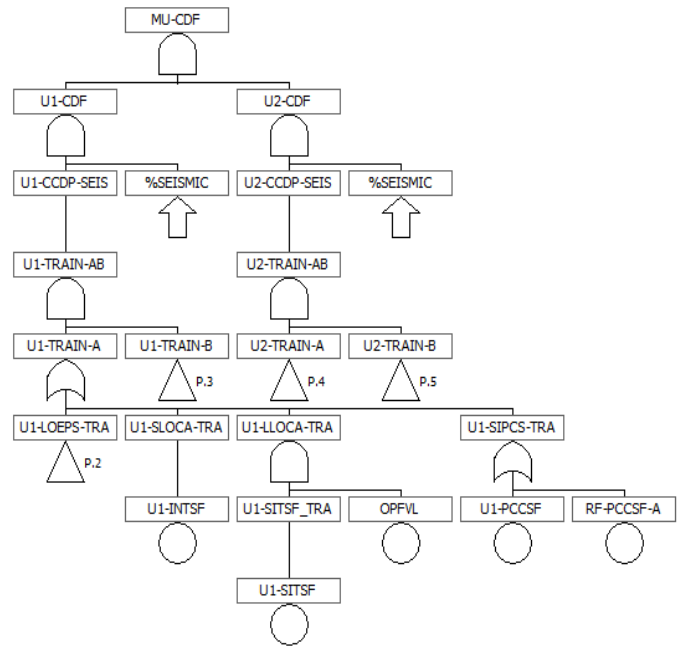
Figure 11. MUCDF fault tree simplified by the full correlation assumption (Model B). Table 4. Seismic failures of redundant/identical components in seismic MUPSA.